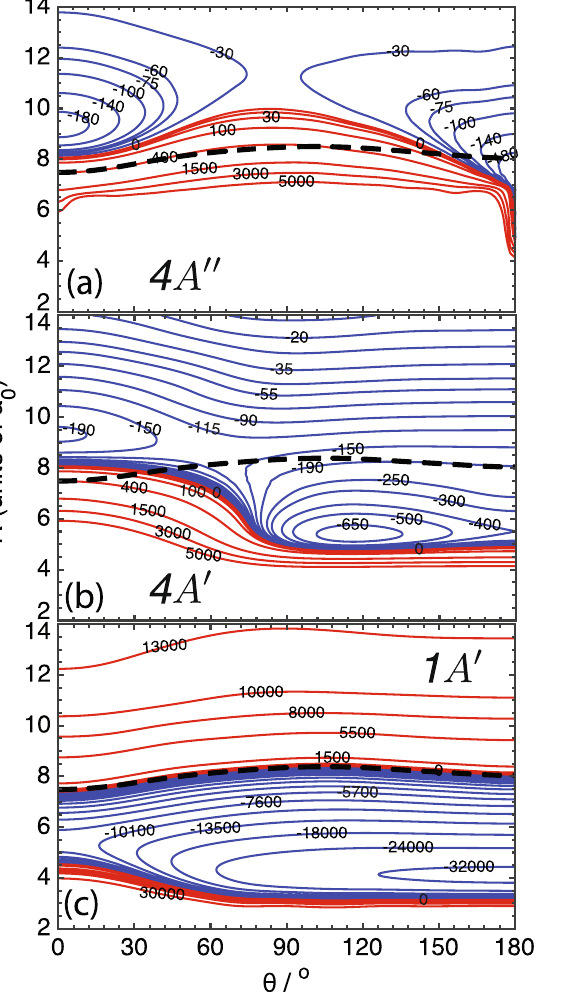
Figure 2. Contour plots of diabatized non-relativistic Sr + OH PESs. ( a – c ) Contour plots of 4 2 A ′′ ( F 2 �) , 4 2 A F 2 �) , and 1 2 A X 2 � ′ ( ′ ( + ) states, respectively, as functions of Jacobi coordinates R and θ . Red and blue contours are labeled by potential energies in the units of cm − 1 . The dashed black curve in each panel corresponds to locations where energies of the 1 2 A ′ and 4 2 A ′ states are equal. ( d ) Contour plot of the 1 2 A X 2 � 4 2 A F 2 �) (nearly-vertical blue curves) states as functions of Jacobi coordinates ′ ( + ) (red curves) and ′ ( 180 R and r for the collinear Sr-O-H arrangement with θ ◦ . The seam of conical intersections is shown by the = green curve. Contours are labeled by energies are in units of cm − 1 and spaced by 1000cm − 1 for both potentials. OH ( X 2 �) dissociation limit. The OH separation is fixed at r The zero of energy is at the Sr ( 1 S ) +